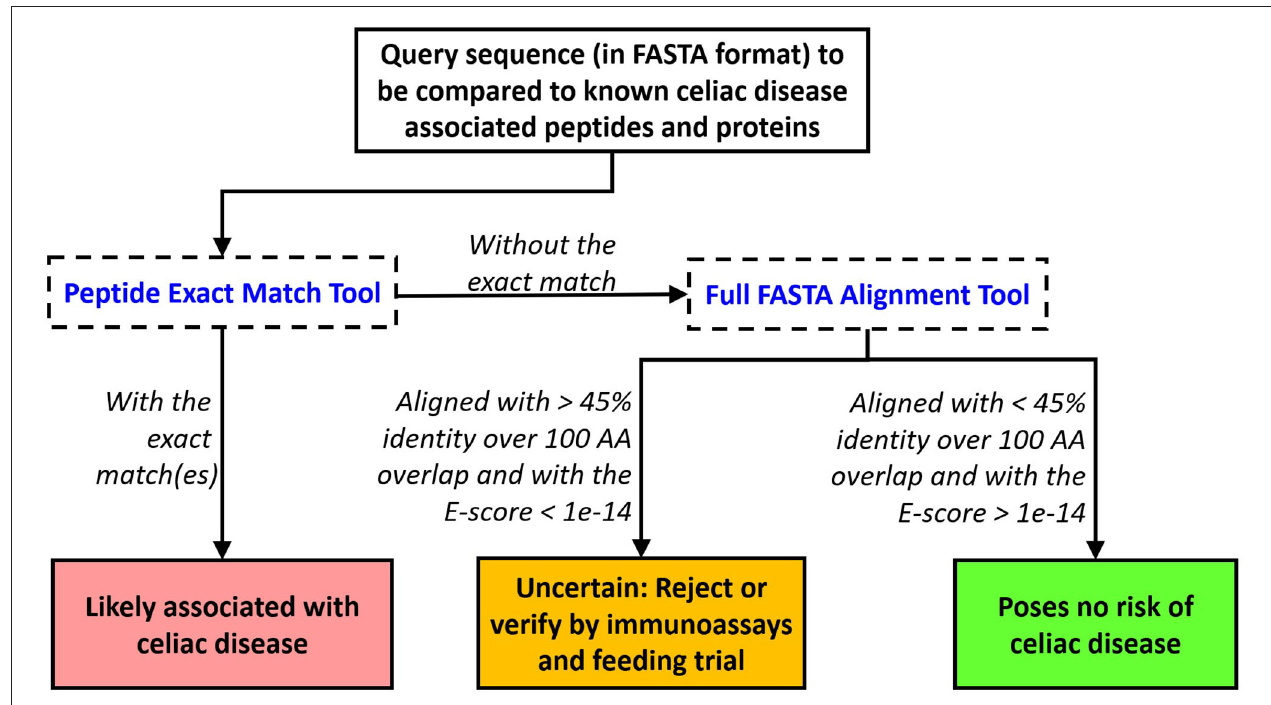
FIGURE 3 | Proposed evaluation criteria to predict the likelihood of a query protein to cause elicitation of CeD. An exact match to any of the 1,041 peptides indicates probable rejection. Alternatively, a FASTA3 alignment with an E -score limit of 1e-14 and minimum alignment length > 100 AA with an identity percent of the protein at 45% should trigger testing or